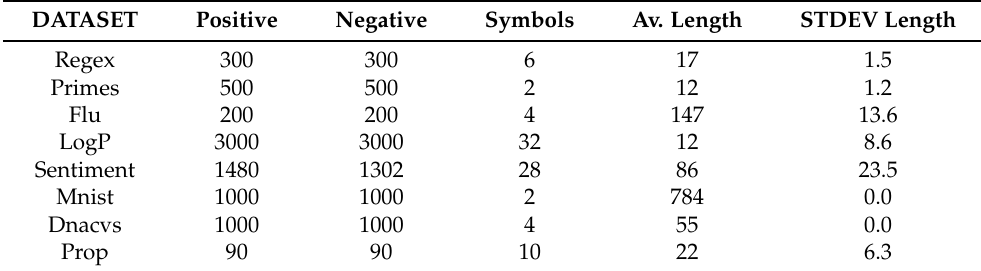
Table 3. Datasets